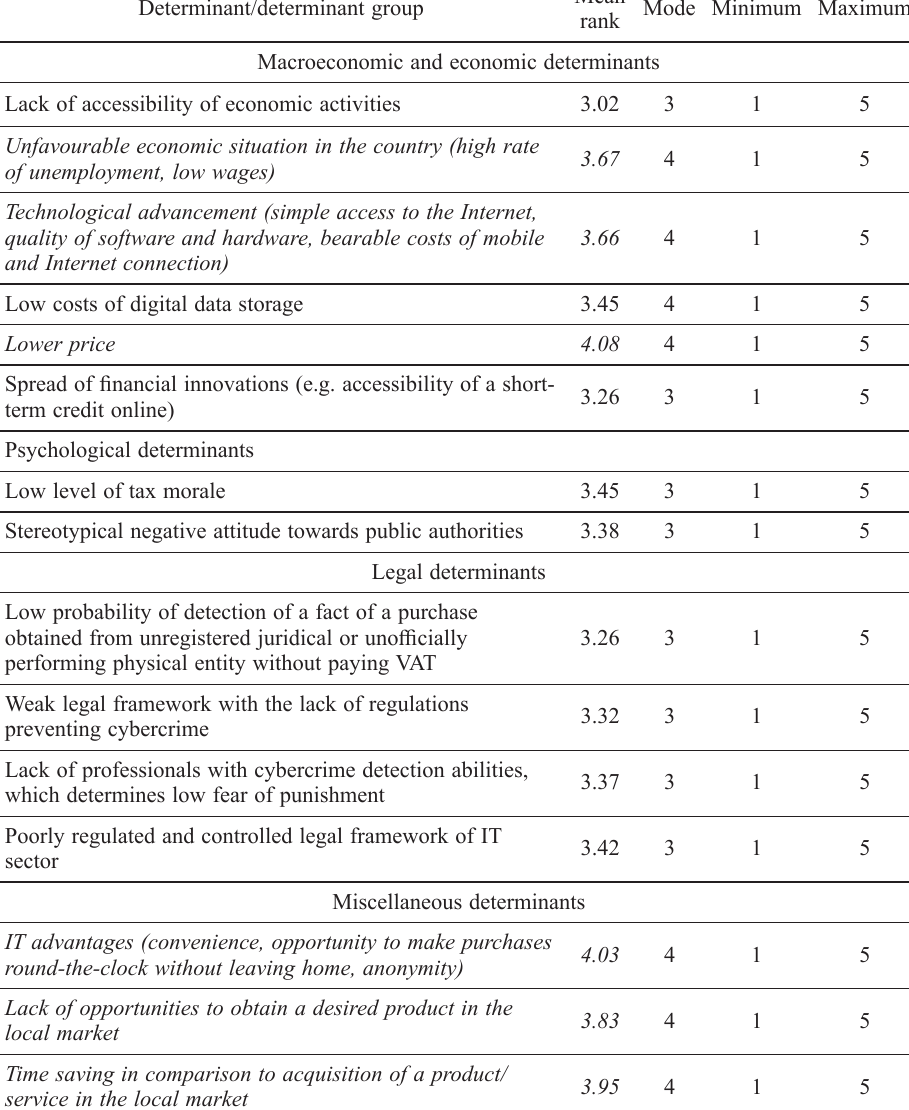
Table 2. The determinants of acquisition of goods/services from digital shadow markets (compiled by the authors with reference to the survey results) Determinant/determinant group